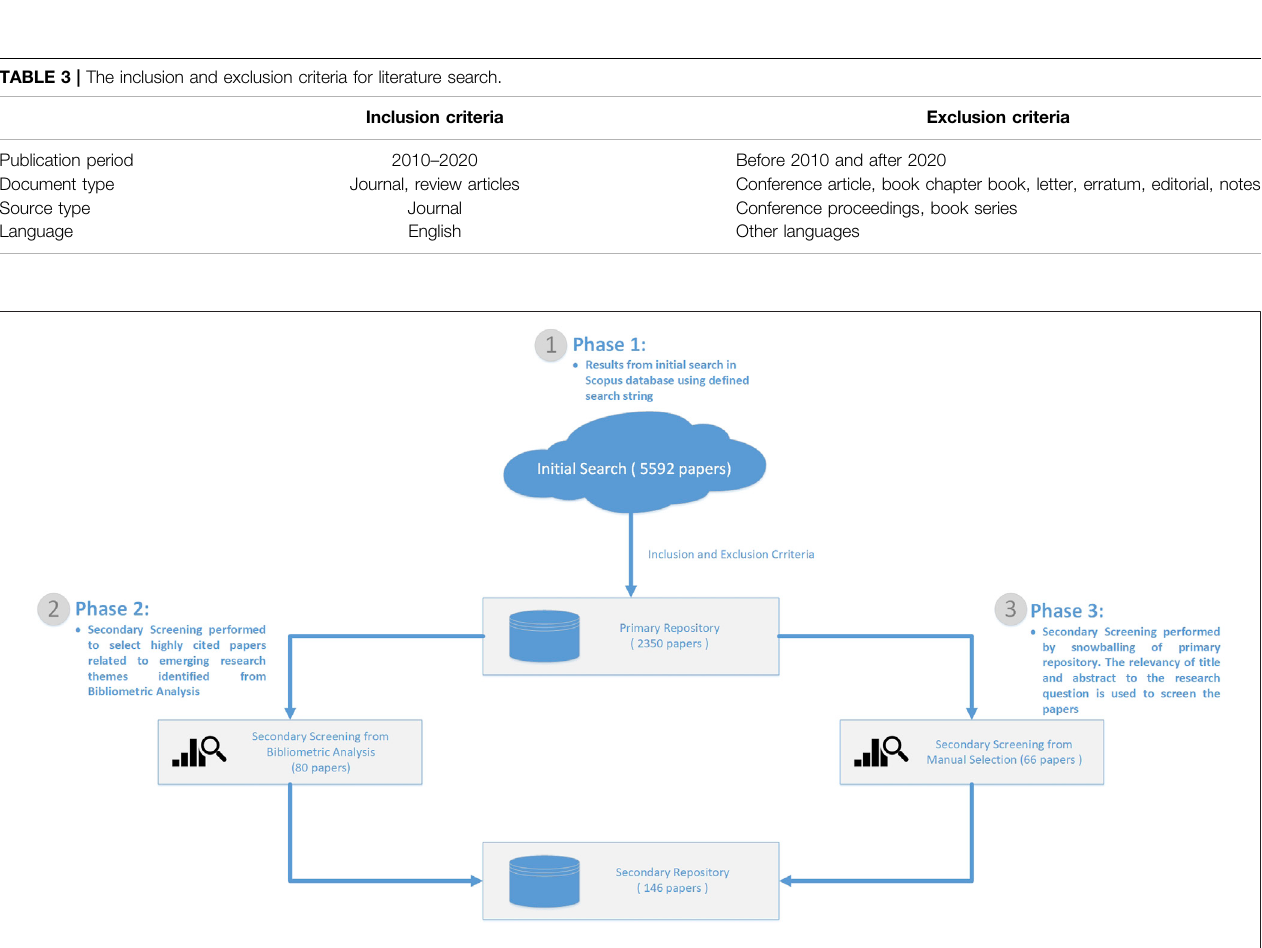
Frontiers in Energy Research |